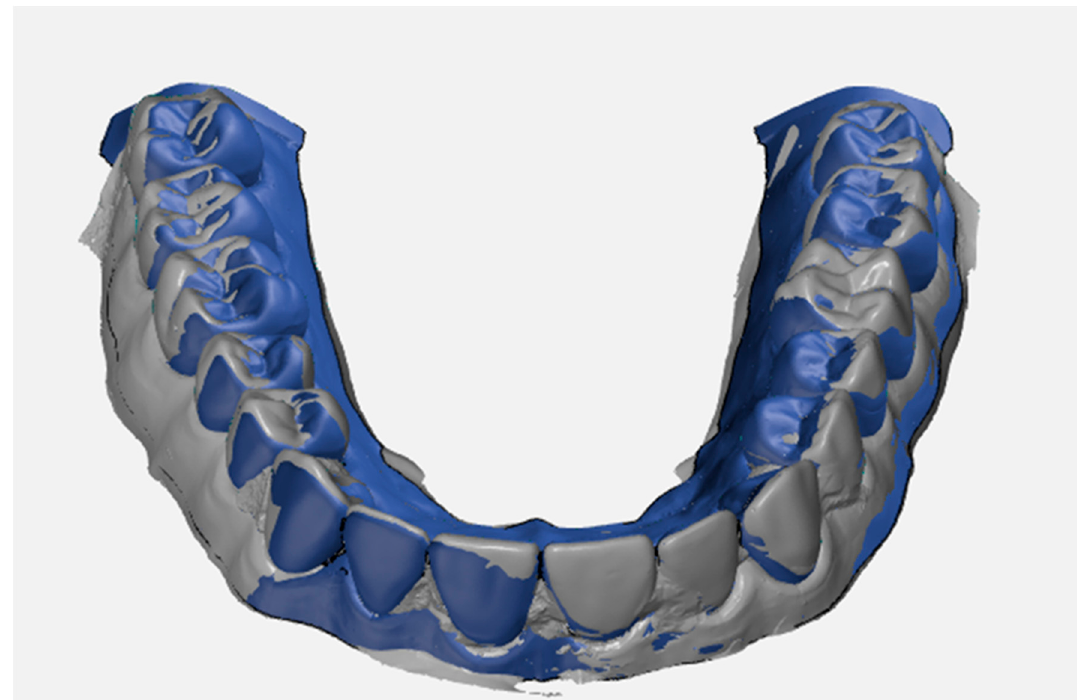
Figure 2. Over-imposition between reference model and plaster model.